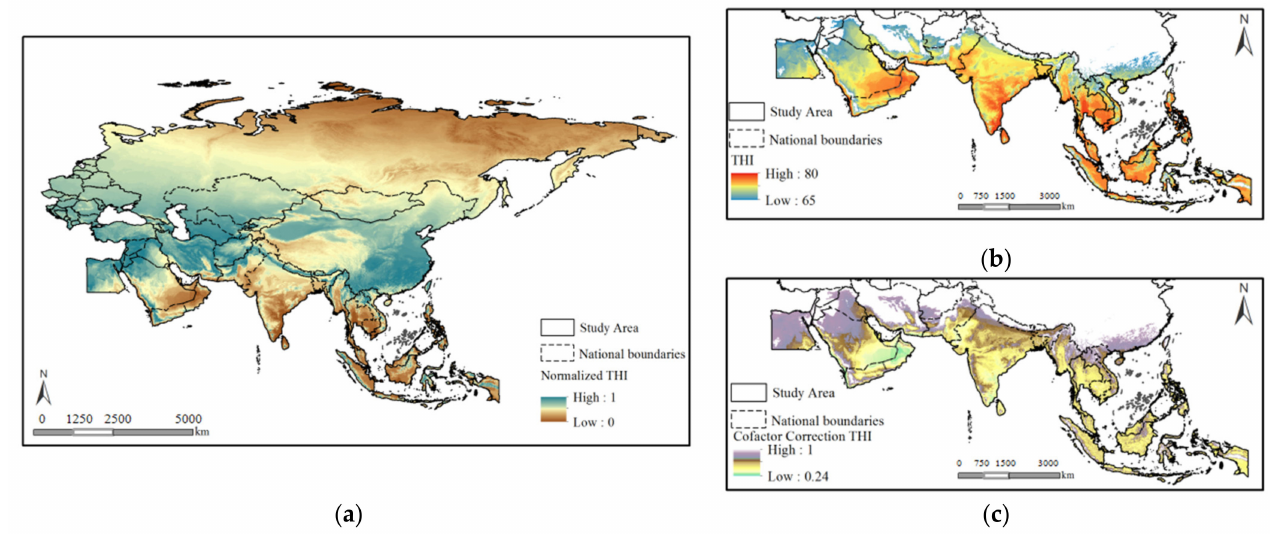
Figure 4. Piecewise corrected NTHI values for the BRI area. Note: ( a ) the normalized THI of the BRI, ( b ) the original THI of the BRI, and ( c ) the cofactor correction THI of the